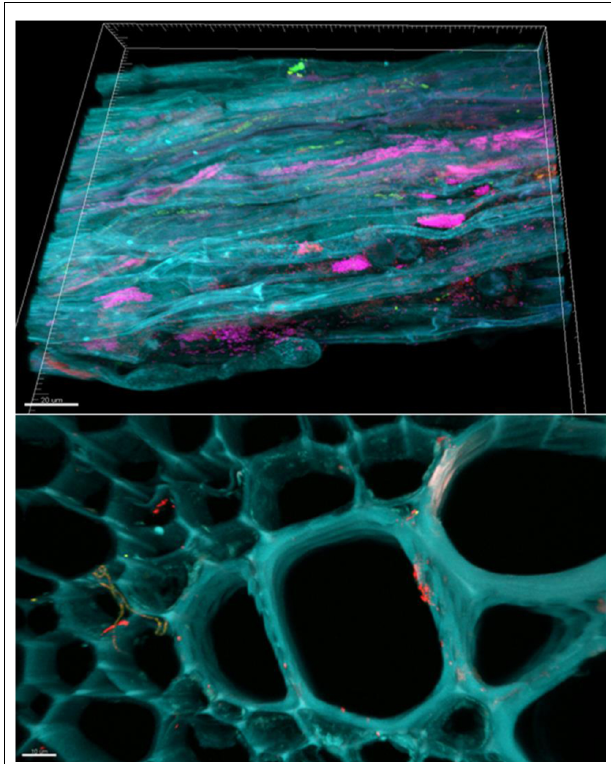
FIGURE 1 | Bacterial micro-colonies in the rhizosphere and endosphere visualized by fluorescence in situ hybridization (FISH) and confocal laser scanning microscopy(CLSM). The rhizosphere microbiome of lettuce is dominated by Betaproteobacteria (purple) forming dense colonies on the root surface.The endosphere is shown as section of the main root of a lettuce plant.While unspecifically labeled bacteria are in red, Alphaproteobacteria (orange-green) are to be seen as colonies as well as filamentous